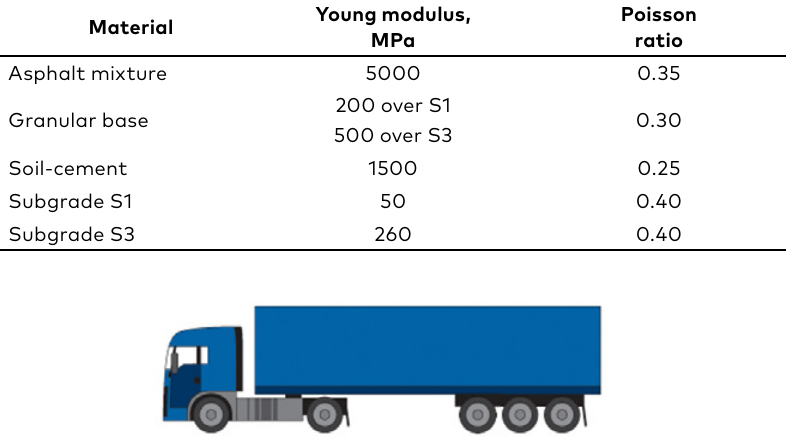
Figure 2. Heavy vehicle T2S3 configuration (modified